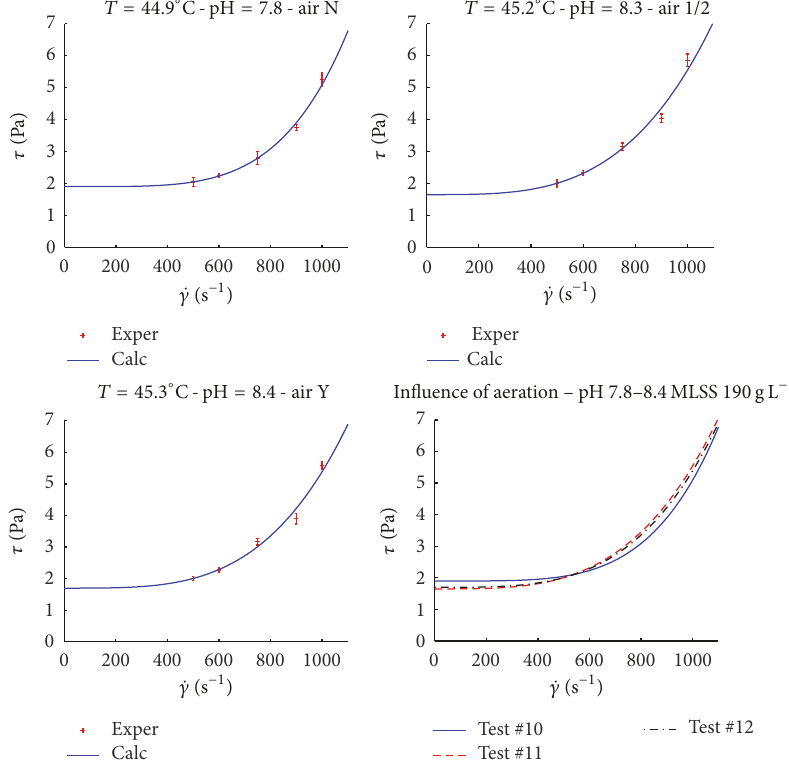
(b) Shear stress versus rate of deformation (MLSS 190gL −1 ). Lower right-hand panel compares calculated values for pH condition around 7.8–8.4 Figure 9: